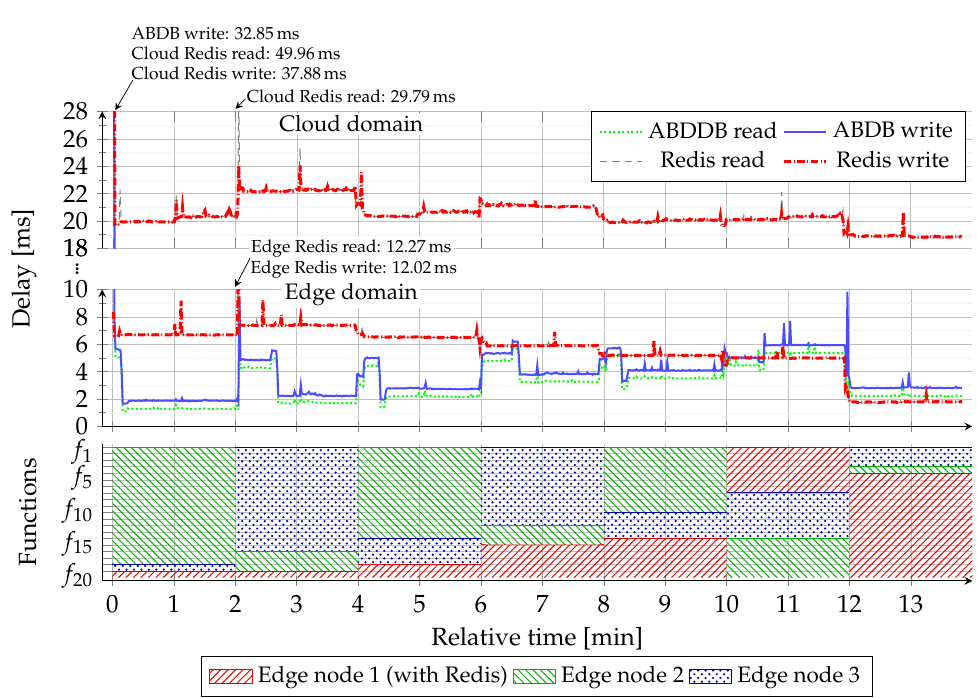
Figure 10. Comparison of ABDB and Redis access performance ( top ) while relocating functions among nodes according to a predefined scheme ( bottom